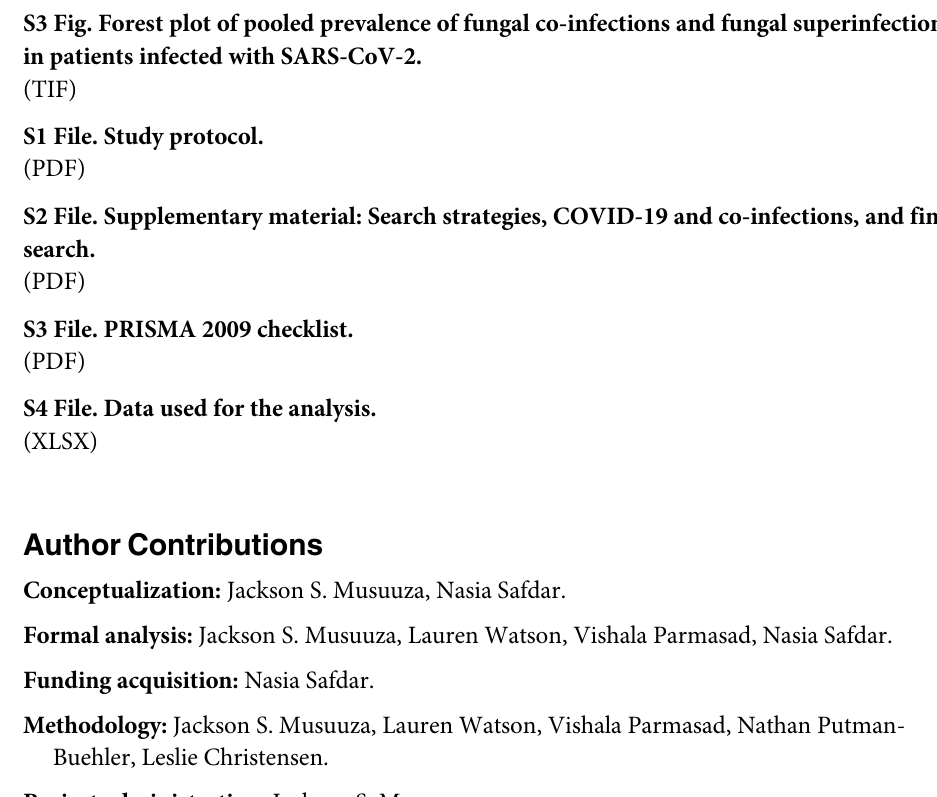
S2 Fig. Forest plot of pooled prevalence of bacterial co-infections and bacterial superinfec- tions in patients infected with SARS-CoV-2. S3 Fig. Forest plot of pooled prevalence of fungal co-infections and fungal superinfections in patients infected with